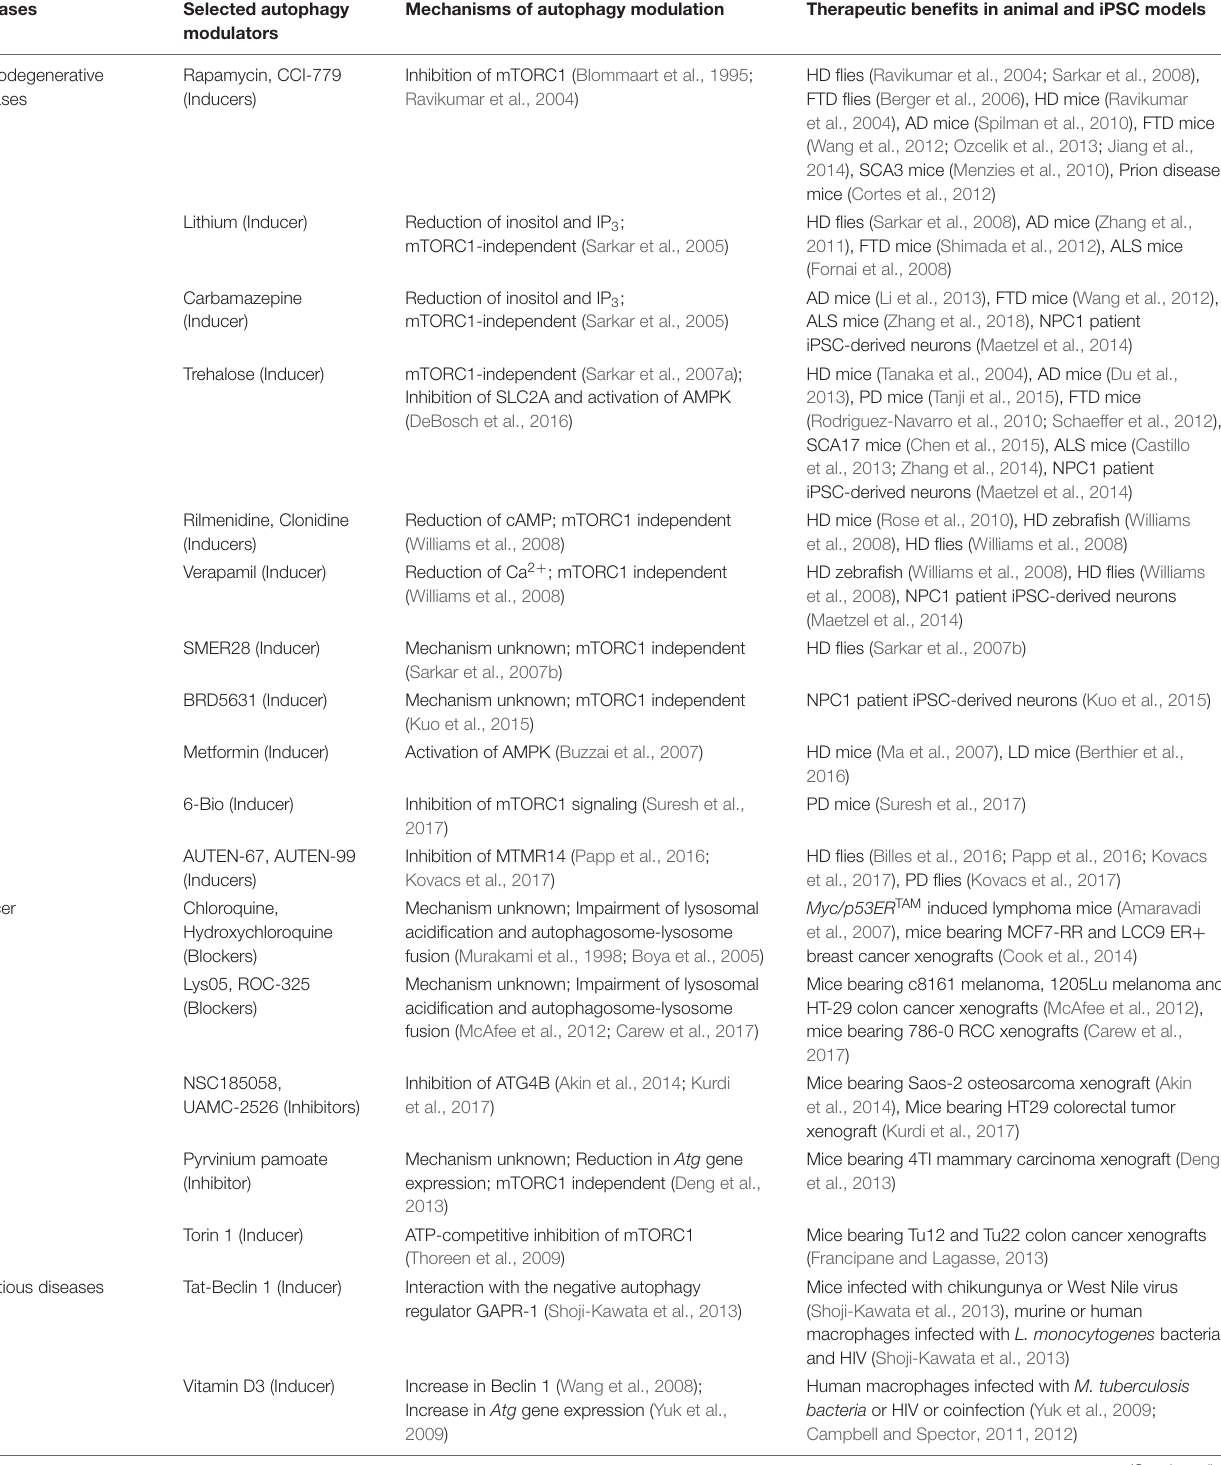
TABLE 2 | Therapeutic benefits of autophagy modulators in diverse human